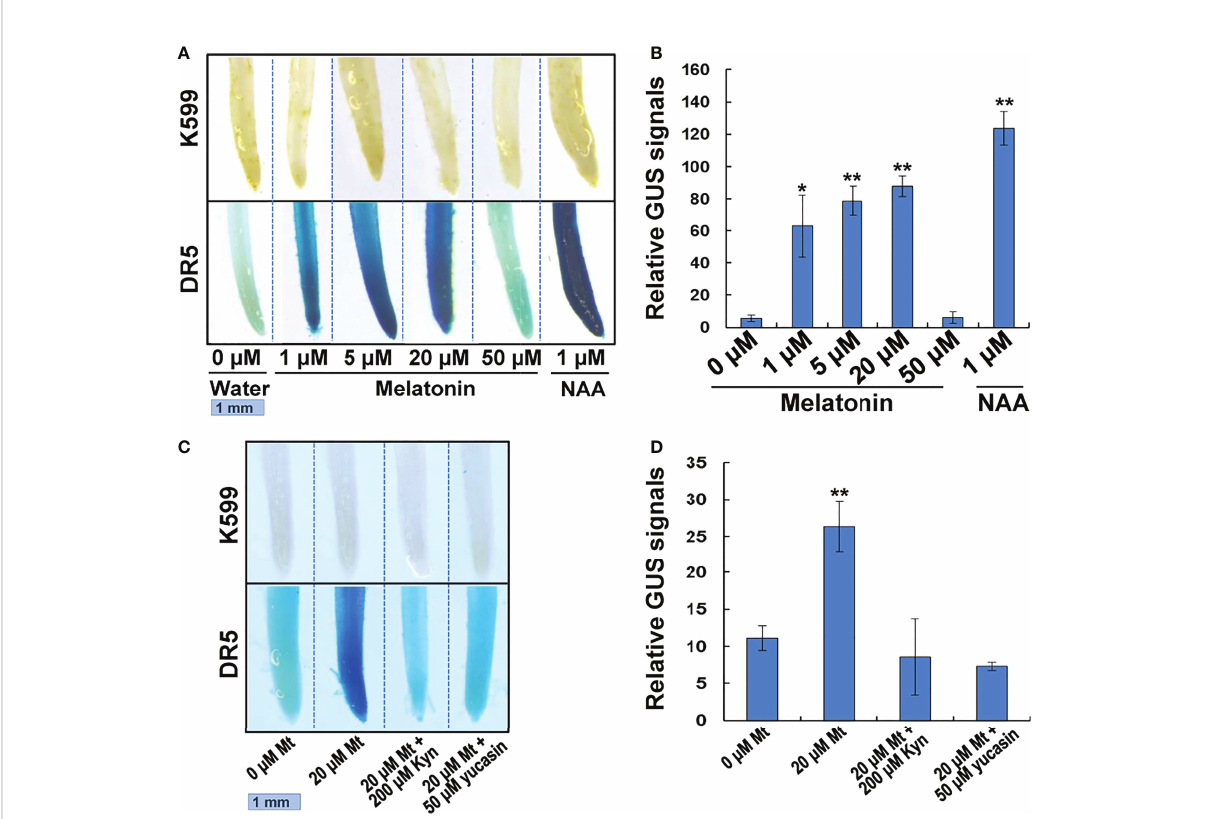
FIGURE 7 GUS staining of melatonin or NAA treated transgenic soybean roots. (A) GUS staining analysis. Transgenic hair roots transformed with DR5: GUS gene were treated with melatonin or NAA for 24h. (B) Quantitative GUS signals. Relative GUS signals = (Blue light intensity of DR5 roots)/(Blue light intensity of K599 roots). Three roots of each concentration were measured. Value indicates means ± SD (n=3). Asterisks indicate signi fi cant differences (*P < 0.05 and **P < 0.01) compared to that of untreated roots (0 m M). (C) GUS staining. Transgenic hair roots transformed with DR5: GUS gene were treated with melatonin and IAA biosynthesis inhibitor for 24h. (D) Quantitative GUS signals. Value indicates means ± SD (n=3). Asterisks indicate signi fi cant differences (**P < 0.01) compared to that of untreated roots (0 m